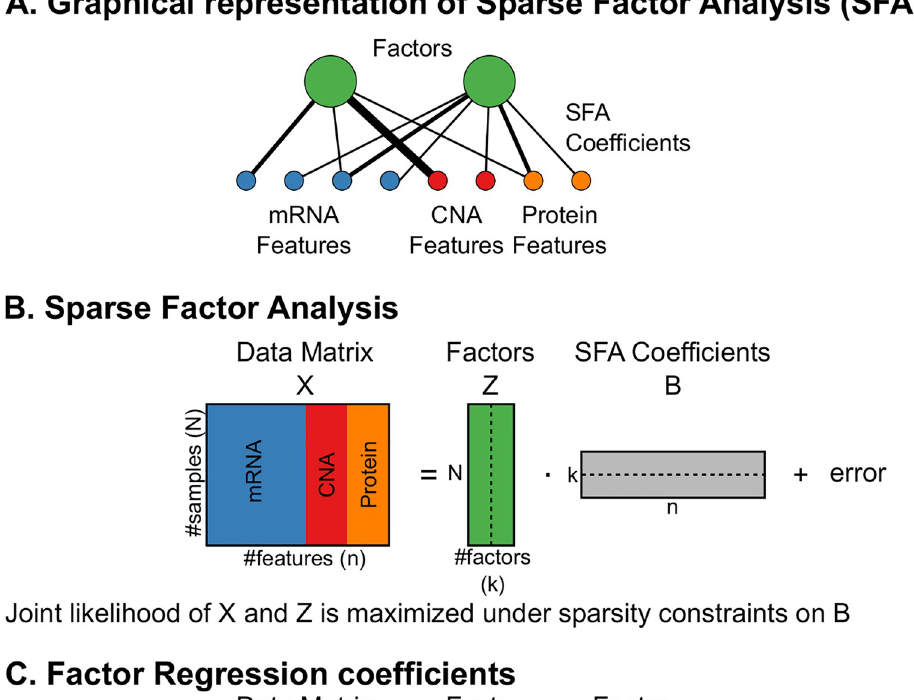
Fig 1. Overview of FuncSFA. A: Graphical representation of Functional Sparse-Factor Analysis (FuncSFA). The green circles represent the factors, and the red, blue and yellow circles at the bottom represent the observed variables, with the colors representing the data types and each circle representing an individual variable (i.e. the expression of a gene or protein, or the copy number of a gene). The black lines connecting the individual variables to the factors represent the regression coefficients. B: Graphical representation of the mathematical concepts of SFA with X representing the N × n data matrix, Z the N × k obtained factor matrix and B the k × n factor coefficients. C: Graphical representation of the computations of the factor expression coefficients. The coefficients represented by the k × n m matrix C are obtained by regressing the N × n m RNA expression matrix, X m , on the N × k factor matrix Z. D: The gene-set enrichment analysis designed to assign biological processes or pathways to the obtained factors. E: Application of the